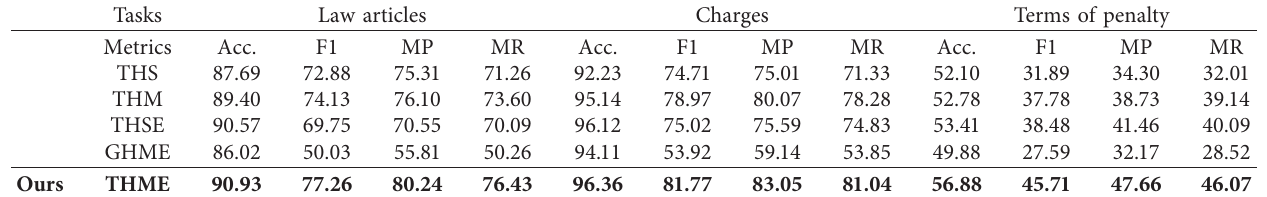
Table 7: Ablation study on